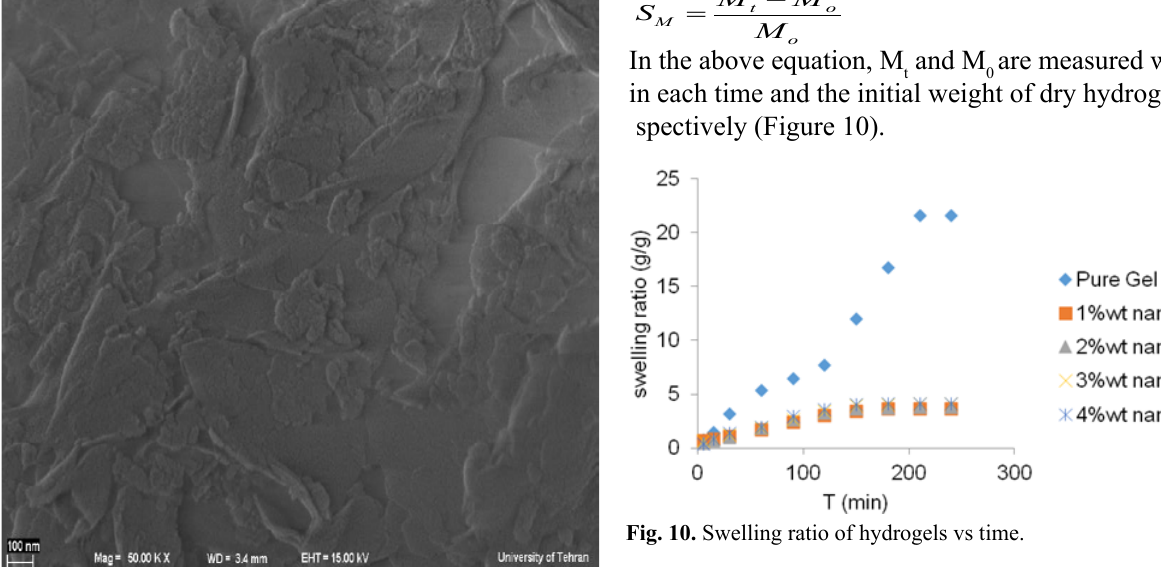
Fig. 8. SEM image for pure montmorillonite nanoclay cloisite 20A.